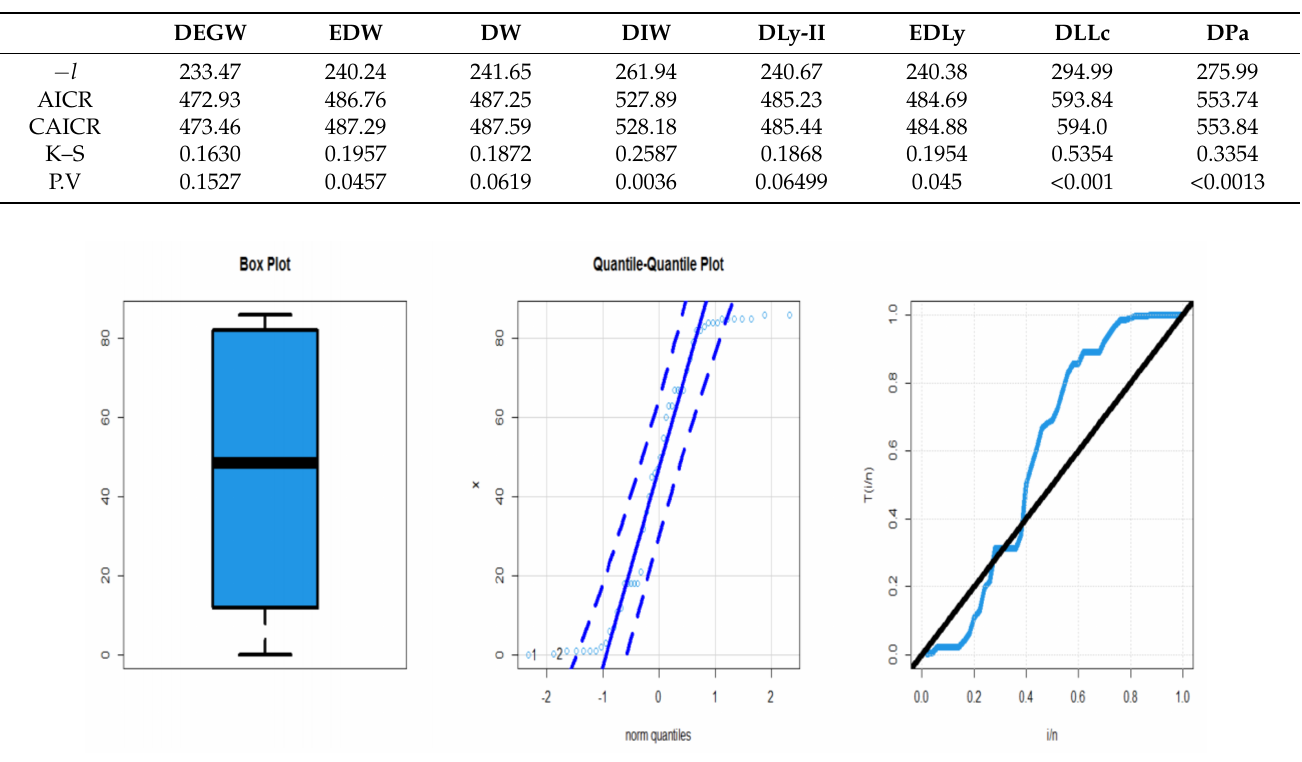
Table 14. The goodness-of-fit test statistics for comparing the competitive models for dataset I.